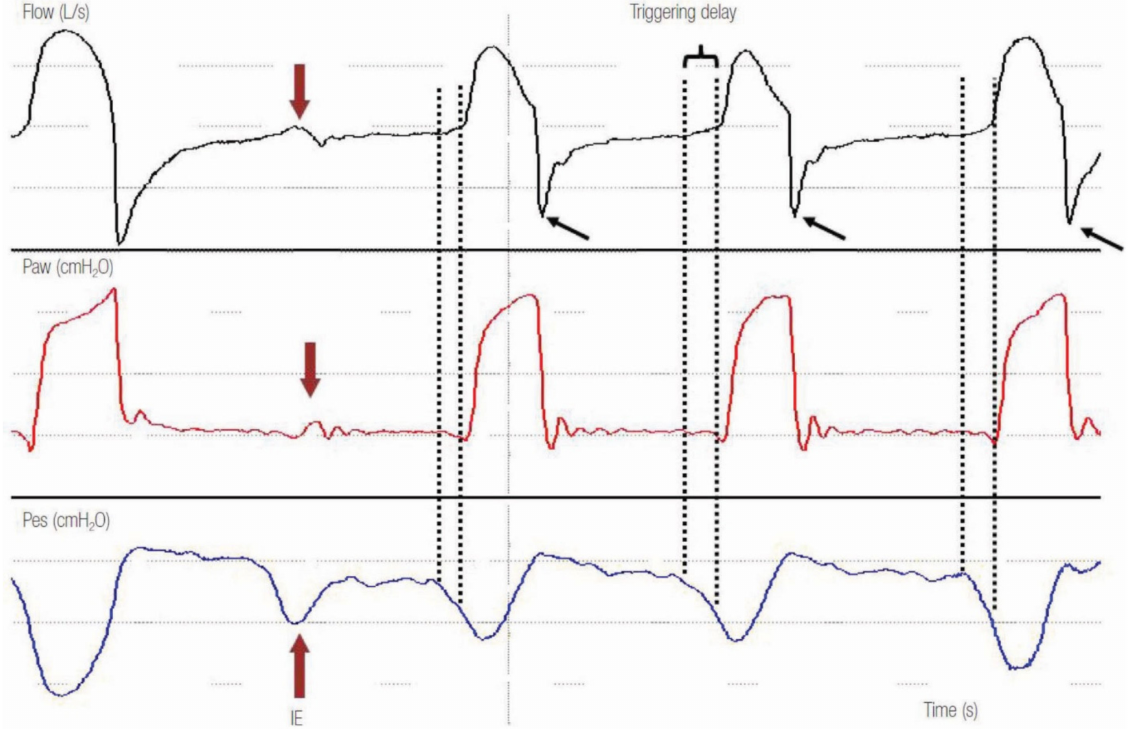
Figure 1. Example of a tracing with ineffective efforts and delayed triggering in pressure support ventilation mode. Note that the second decrease in esophageal pressure (Pes) (red arrow), which represents ineffective effort (IE) of the patient, is not followed by a ventilator breath. At the time of the missed effort, a positive deflection in the airway flow waveform (black arrow) and a negative deflection in the airway pressure (Paw) (red arrow) can be noted. Observe that in every ventilator breath, there is a time gap (delayed triggering) between the start of neural inspiration (first dotted line) and the start of ventilator inspiration (second dotted line). Notice the spike early in expiratory flow (black arrows) after each breath that suggests high airway resistance causing incomplete exhalation and delayed triggering